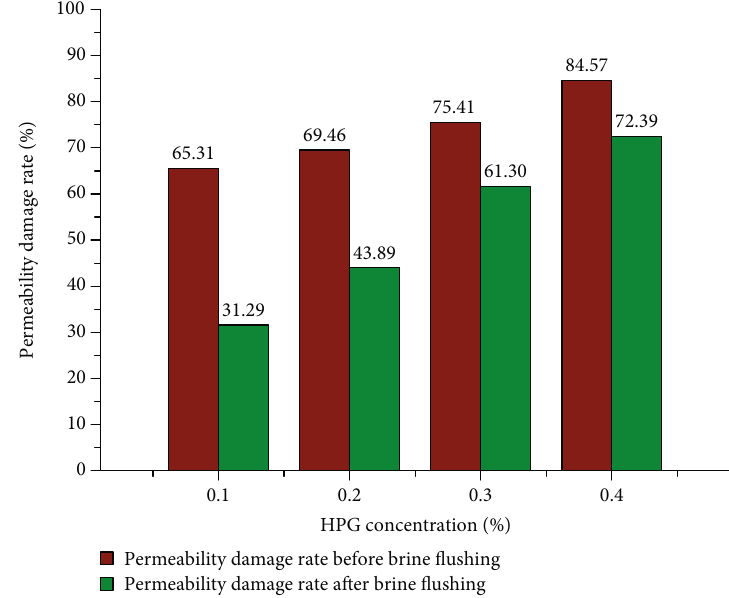
Figure 3: In fl uence of fracturing fl uid concentration on coal sample